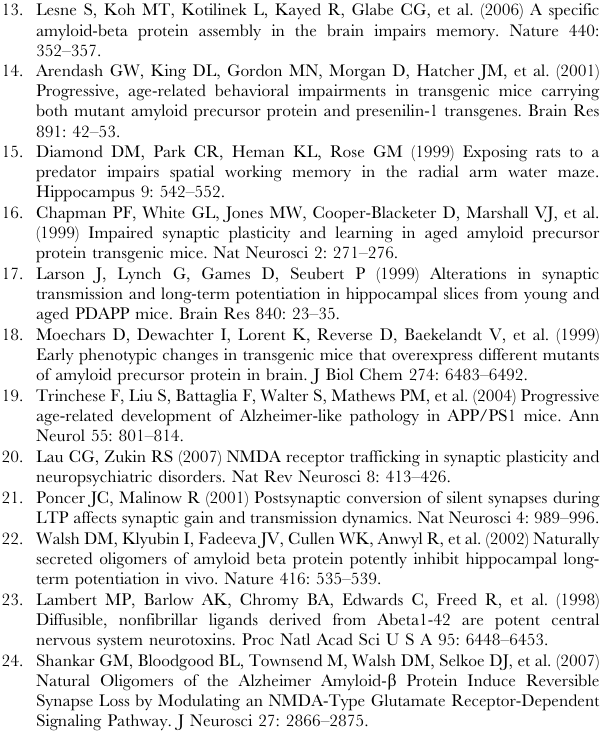
Figure S1 Balance beam, body weight, and swimming